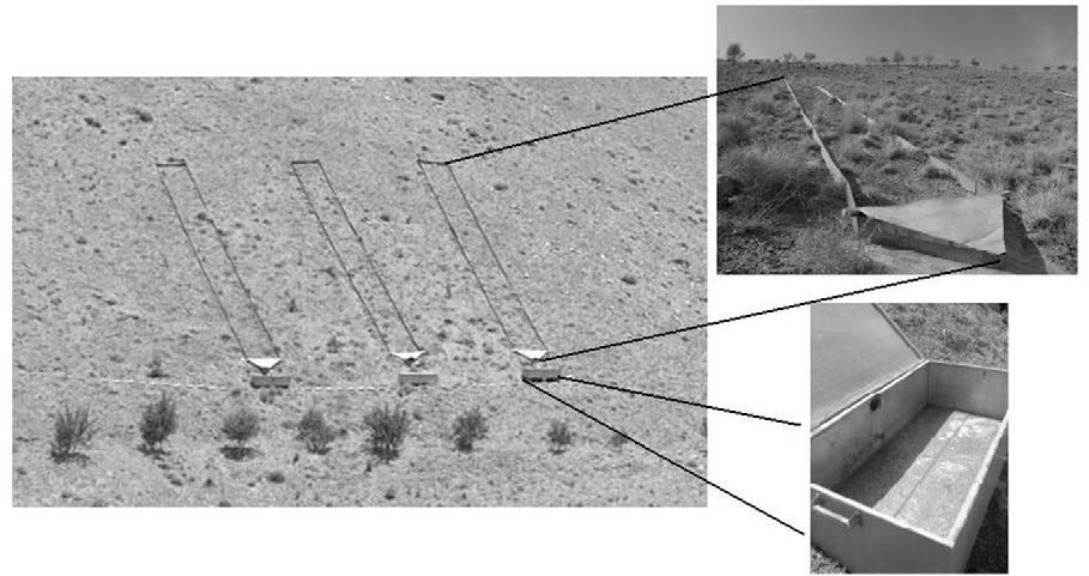
Fig. 2: Erosion plots established in Kakhk experimental watershed